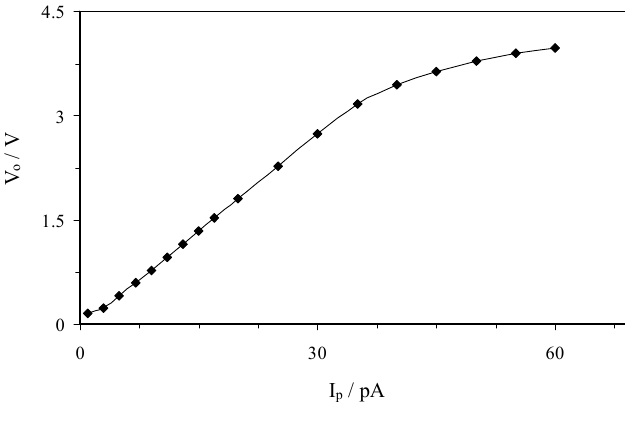
Figure 5. Calibration of the current-to-voltage